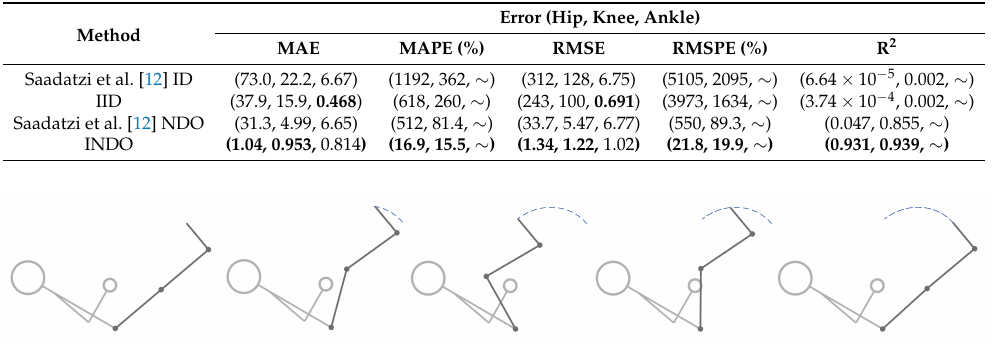
Figure 8. Simulated leg press sequence.